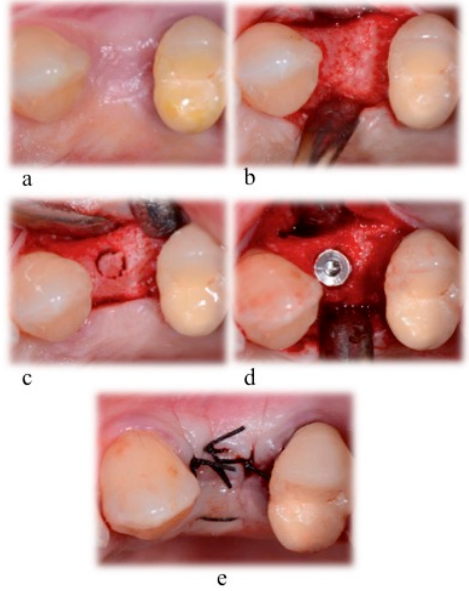
Figure 2. Surgical phases for implant bed preparation and sample harvesting, ( a ) after the infiltration of local anesthesia; ( b ) soft tissue incision and bone exposure; ( c ) hard tissue sample collecting phase; ( d ) implant insertion; ( e ) suture with a 4–0 silk suture.